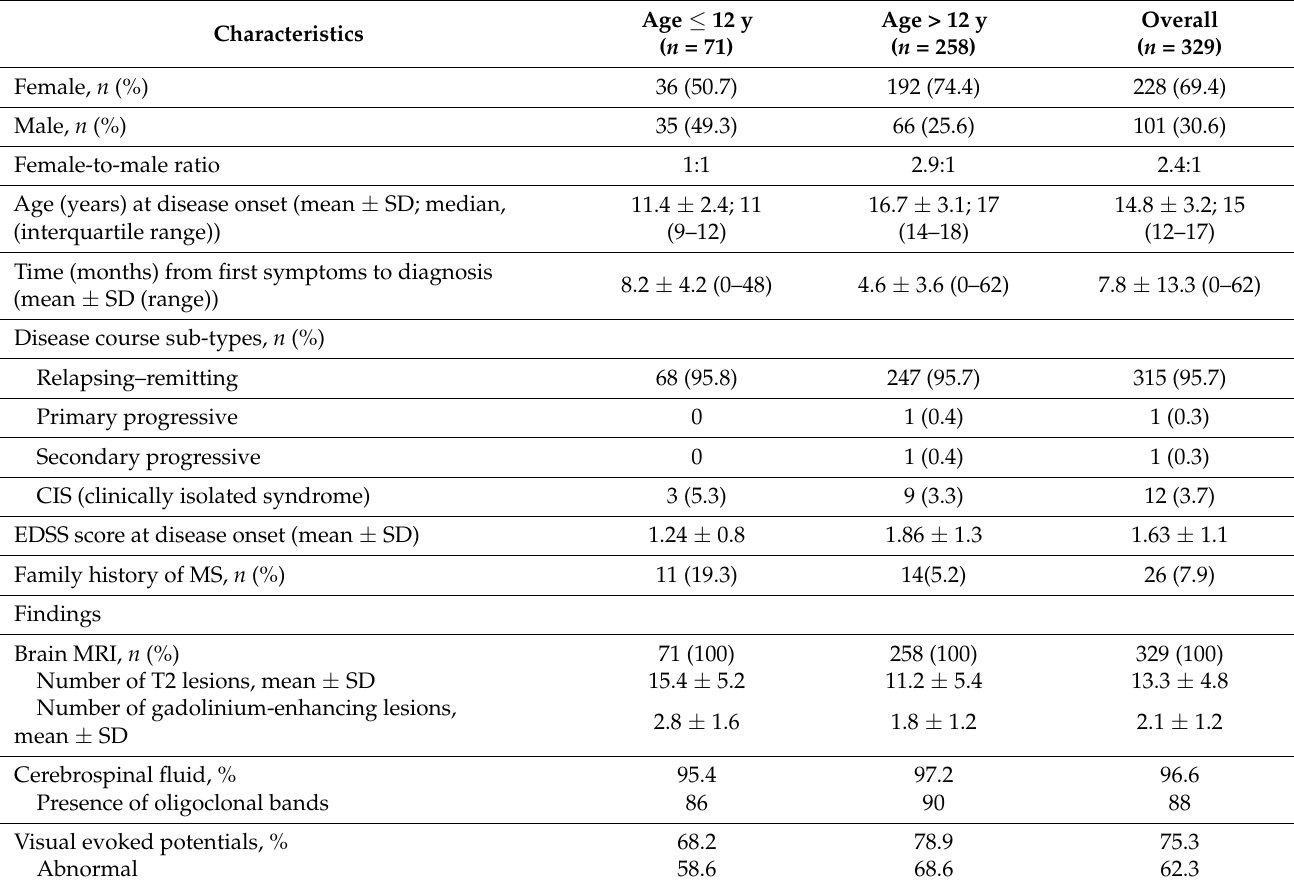
Table 1. Demographic and clinical characteristics of patients with paediatric-onset